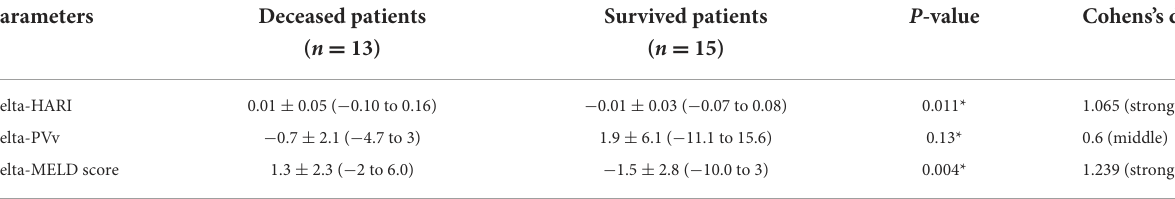
TABLE 6B Subgroup analyses—Differences in perfusion parameters over time predicting mortality in patients with liver